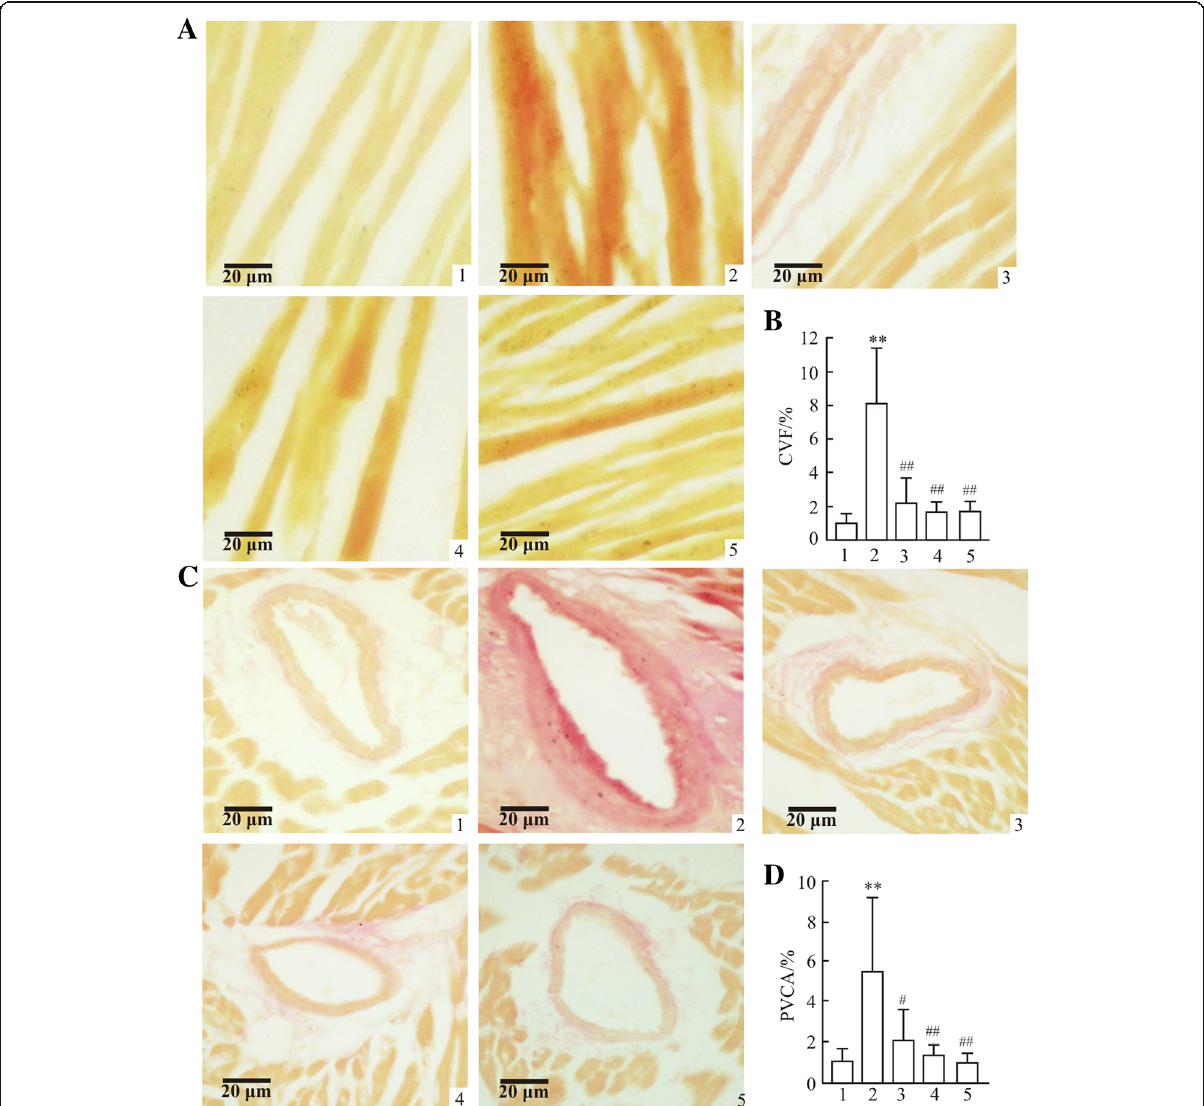
Fig. 5 Effects of polysaccharide extract from XJEK on CVF and PVCA in L -NAME-induced hypertensive mice. Representative image of myocardial fibrosis following VG staining (magnification, ×400). ( b ) Statistic alanalysis of myocardial fibrosis. ( c ) Representative image of perivascular fibrosis following VG staining (magnification, ×400). ( d ) Statistical analysis of perivascular fibrosis. 1,control group; 2,model group; 3, L -NAME+AqE group; 4, L -NAME+XJEK group; 5, L -NAME+fosinopril group. Levels of myocardial and perivascular fibrosis increased significantly in the model group compared with control group. However, these pathological changes could be reversed following AqE for the last 4weeks of treatment and similar effects could be achieved with treatment with the positive control fosinopril. Data are presented as the mean±SD ( n =10). ** P <0.01 vs. control group; # P <0.05, ## P <0.01 vs. model